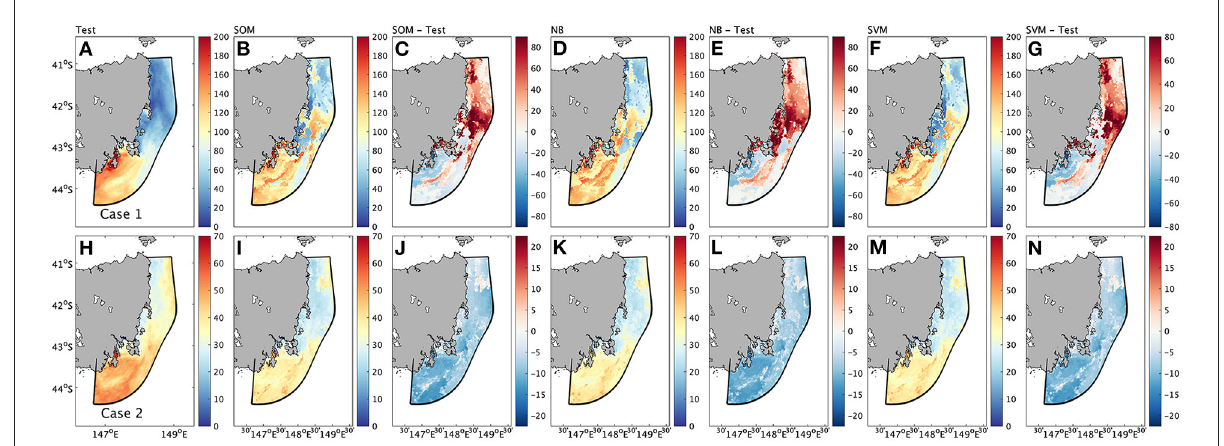
FIGURE11 (A–N) Model predicted annual MHW days and their difference between test data in each experiment. Test data are labelled as “Test”, predicted annual MHW days are labelled by corresponding cluster method (“SOM”, “NB”, “SVM”), and the differences between test data and prediction are labelled as “Test-cluster method” (“Test-SOM”, “Test-NB”,